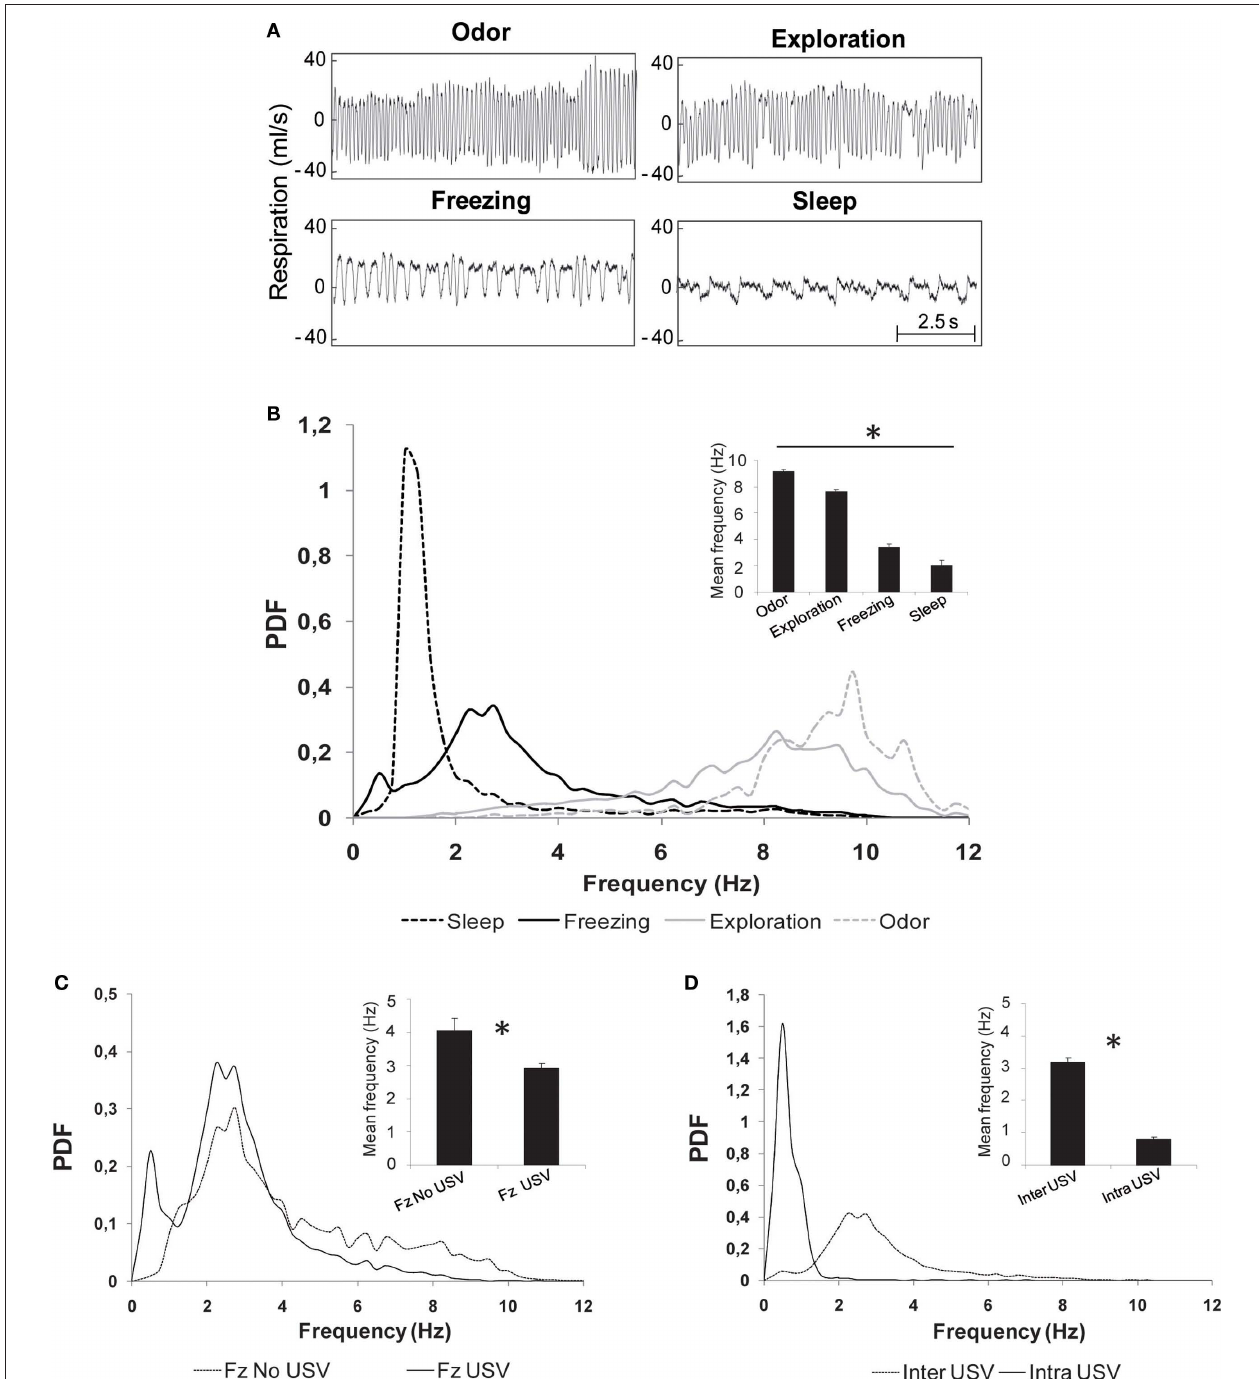
Figure 4 | evolution of respiratory frequency with behavior. (A) Individual examples of respiratory traces observed during four stable behavioral states: odor sampling, exploration, freezing, and sleep. (B) Distribution of respiratory frequencies (probability distribution function: PDF) in the different behavioral states. The distributions were obtained with a 0.25 Hz bin. Insert : mean ± SEM frequency for each behavior. *Significant differences between all the mean values 2 by 2